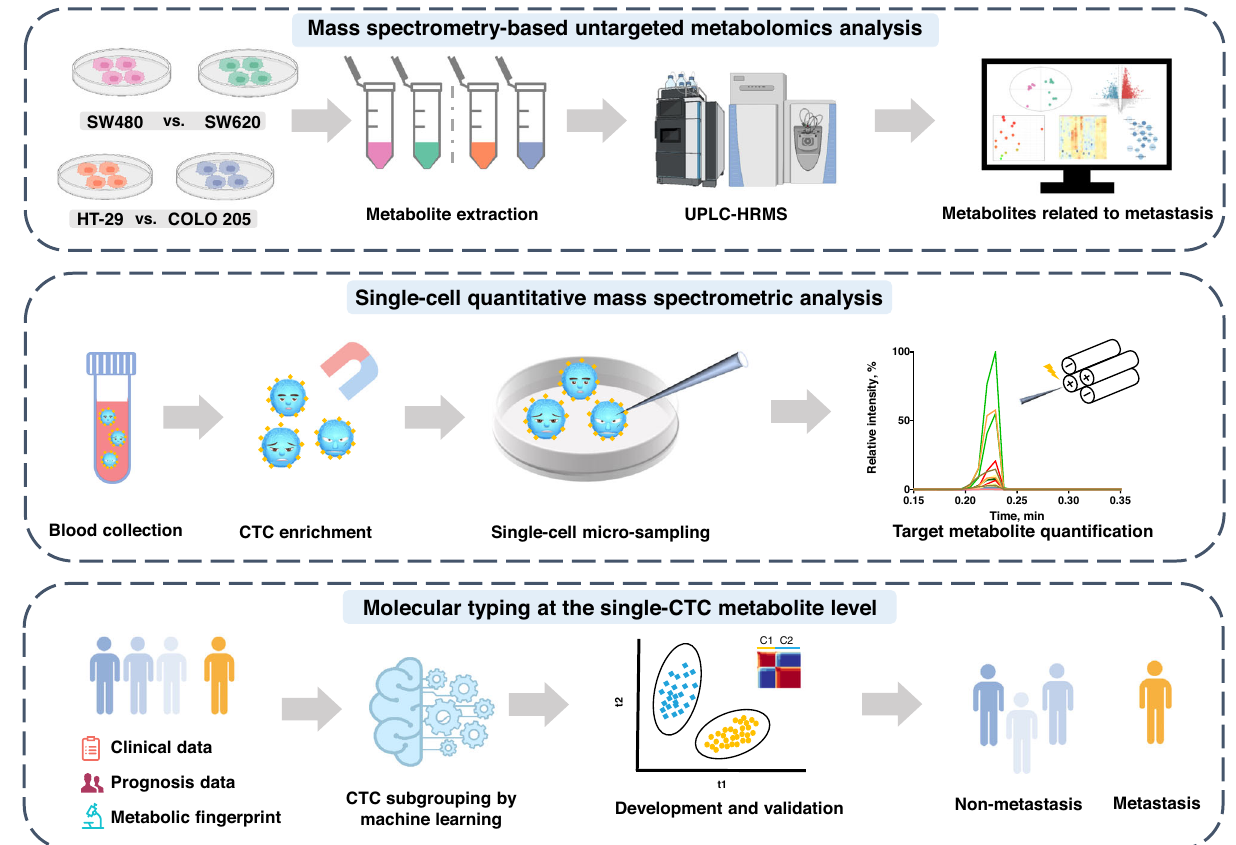
Fig. 1 | Schematic work fl ow of circulating tumor cell (CTC) subgrouping and colorectal cancer metastasis prediction using home-built single-cell quanti- tative mass spectrometry platform. First, two pairs of colorectal cell lines with differential metastatic potential were screened using mass spectrometry-based untargeted metabolomics, and metabolites with differential abundance correlat- ing with cancer metastatic risk were identi fi ed. Then, CTCs were isolated from colorectal cancer patients. Cellular content was extracted from single CTCs, and